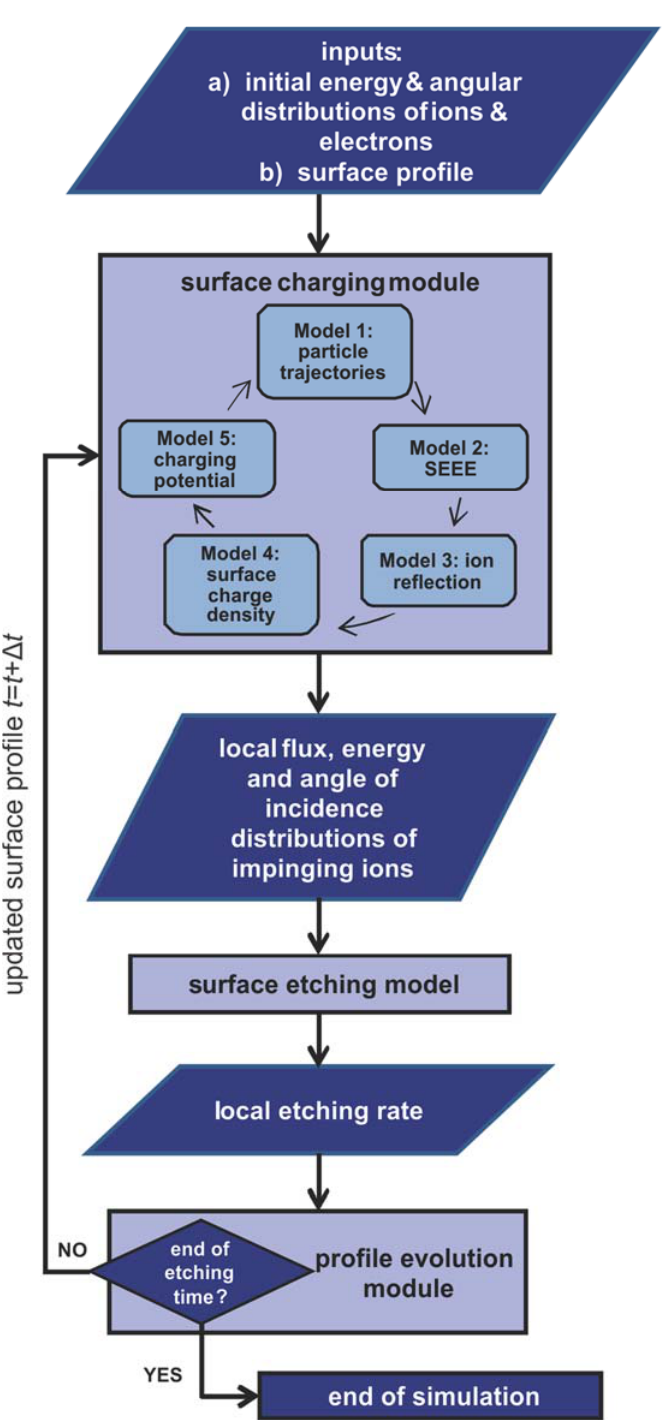
Figure 1. The modeling framework and the procedure of the computations. The coupling among modules of the framework, as well as the flow of data in the framework, is depicted.